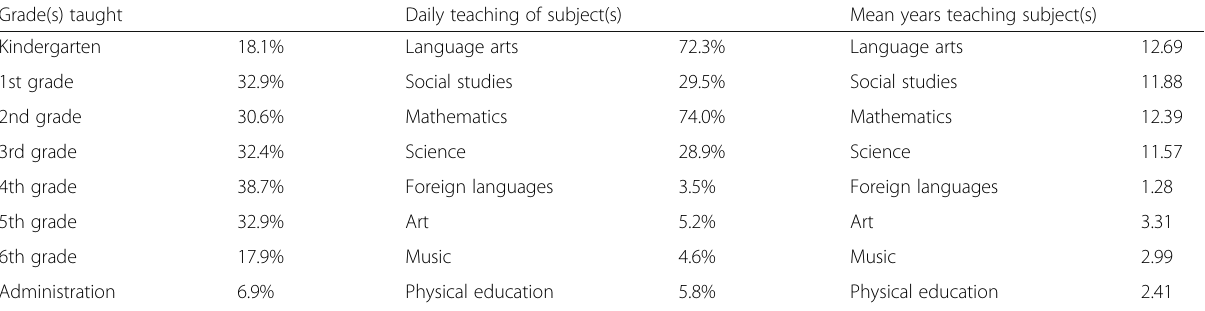
Table 2 Percentage of teachers by grade(s) taught in the previous year, subject(s) taught daily in previous year, and mean years teaching each subject